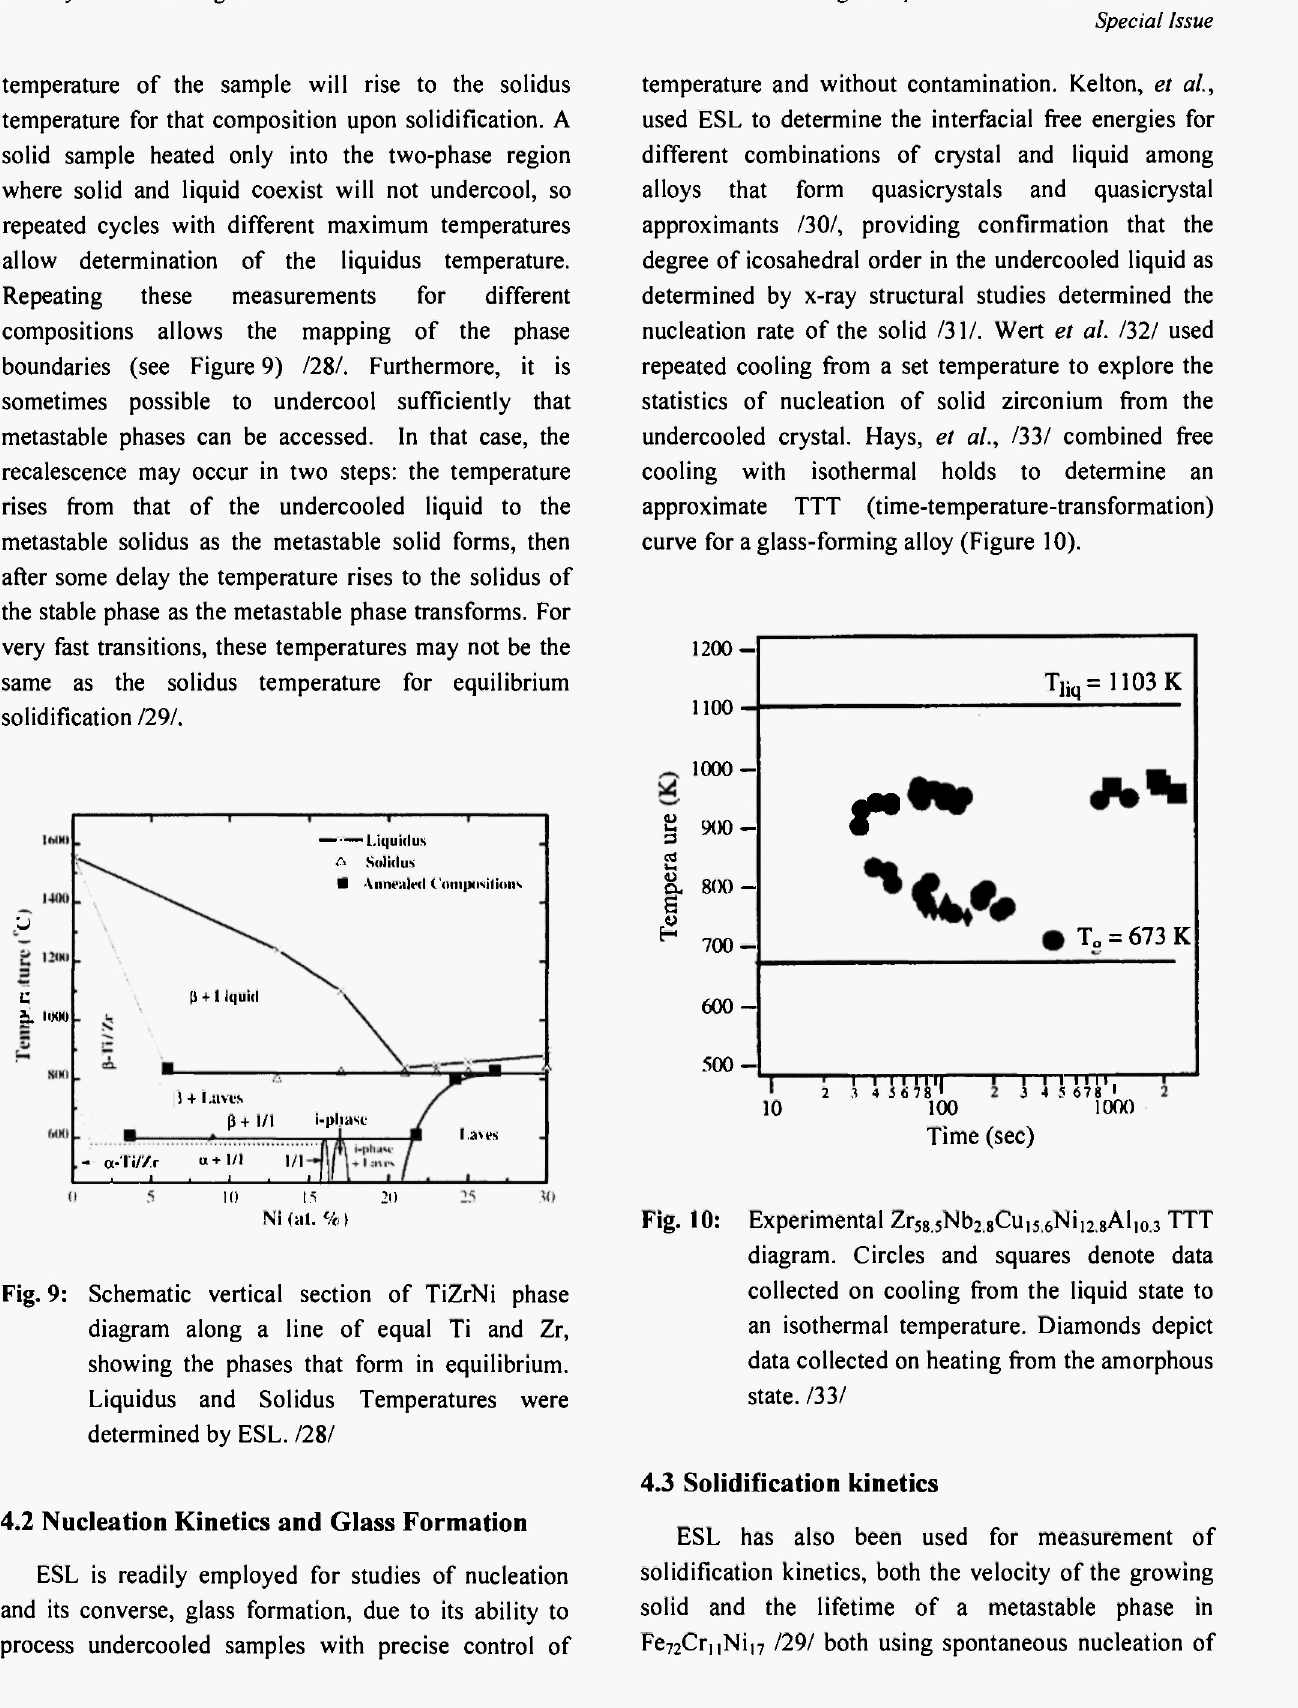
Fig. 9: Schematic vertical section of TiZrNi phase diagram along a line of equal Ti and Zr, showing the phases that form in equilibrium. Liquidus and Solidus Temperatures were determined by ESL. /28/